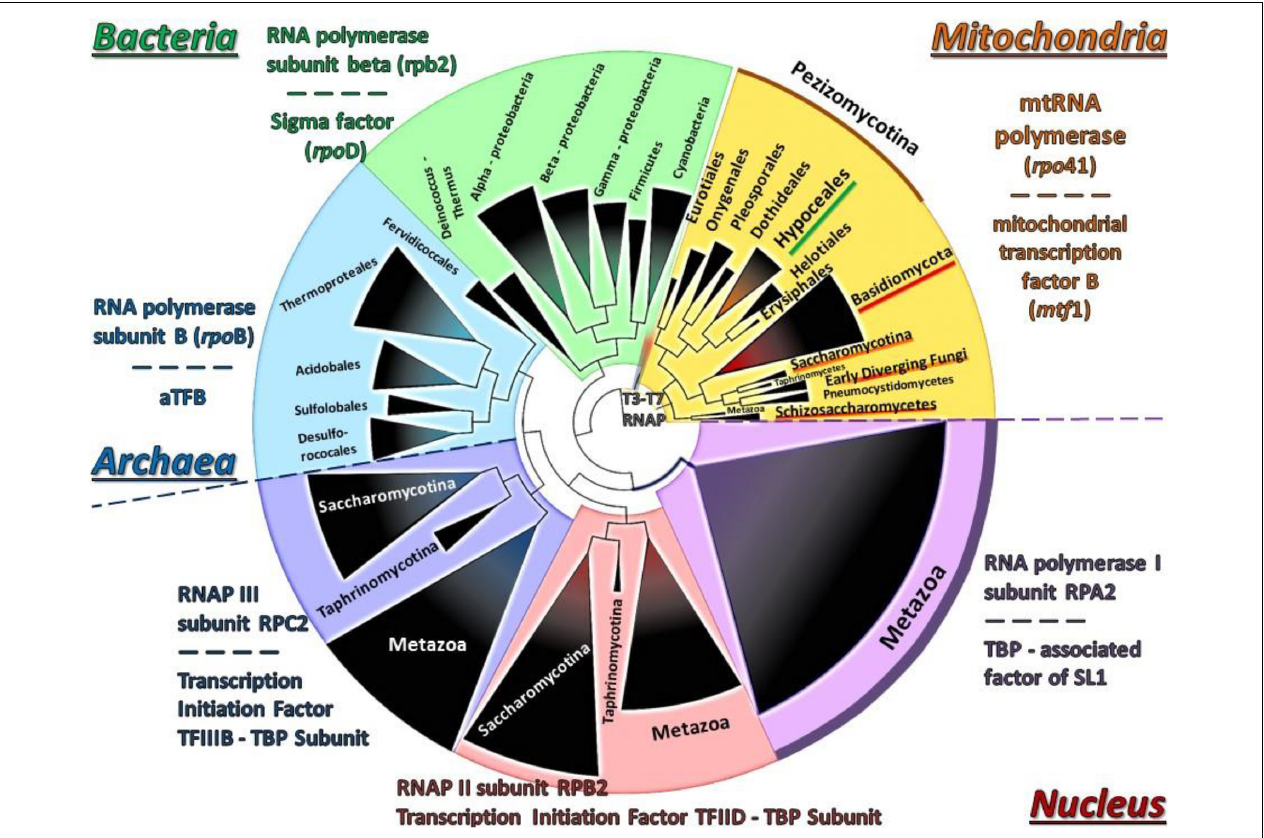
FIGURE 8 | The phylogenetic tree of the concatenated Rpo41-Mtf1 matrix using NJ and RAxML methods. RAxML-bootstrap support was in all topologies above 95% and it is not shown. Gene clusters of organisms belonging to the same taxonomic division are shown in different